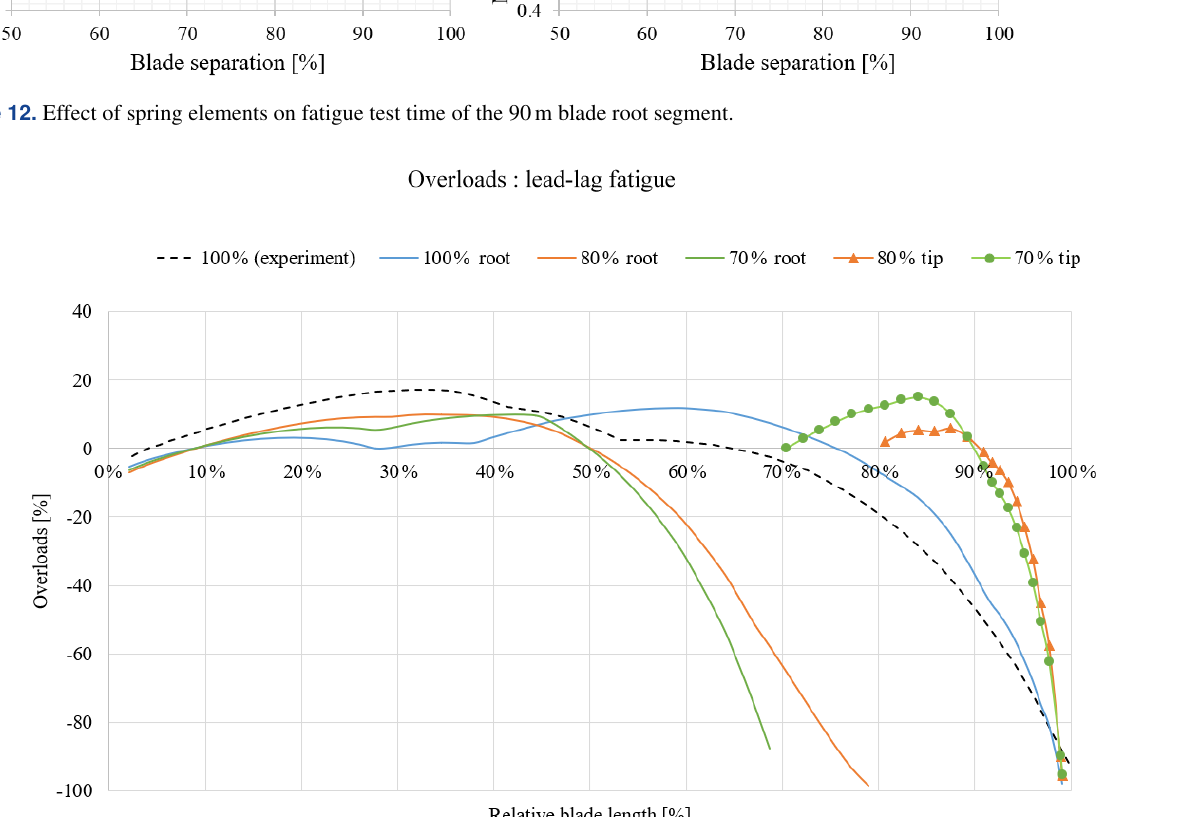
Figure 13. Overload comparison in lead-lag fatigue of the 60m blade (full scale vs.